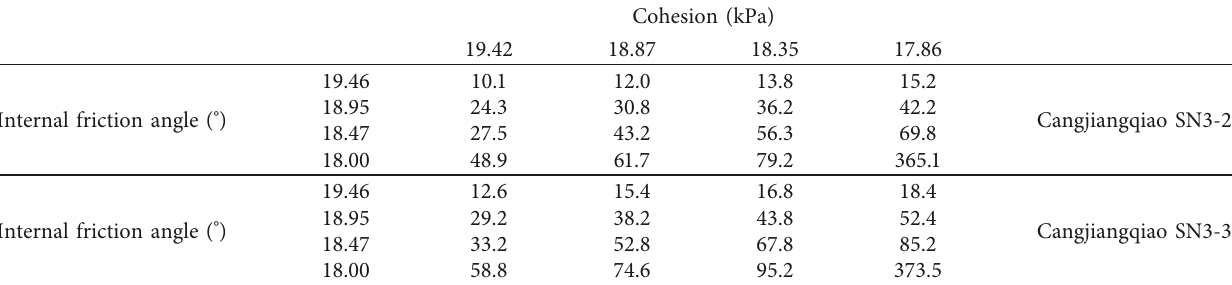
Table 5: Calculated deformation values of Cangjiangqiao landslide (mm).